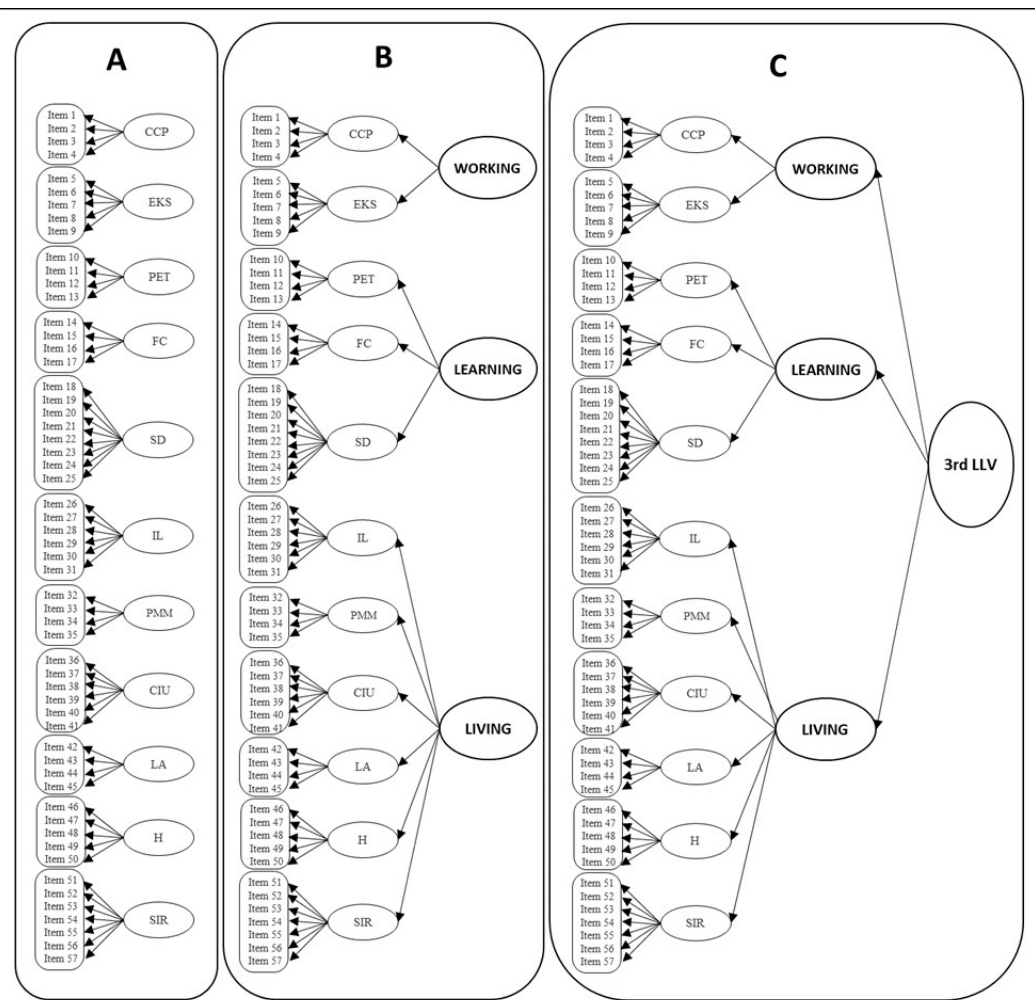
Figure 1. Three models of TPI-AR: ( A ) 1st-order model with eleven separated scales; ( B ) 2nd-order model with 3 higher latent variables; ( C ) 3rd-order model with higher overall latent variable. 3rd LLV = 3rd-level latent variable, CCP = Career Choice and Planning, EKS = Employment Knowledge and Skills, PET = Postsecondary Education/Training, FC = Functional Communication, SD = Self-Determination, IL = Independent Living, PMM = Personal Money Management, CIU = Community Involvement and Usage, LA = Leisure Activities, H = Health, SIR = Social/Interpersonal Relationships.